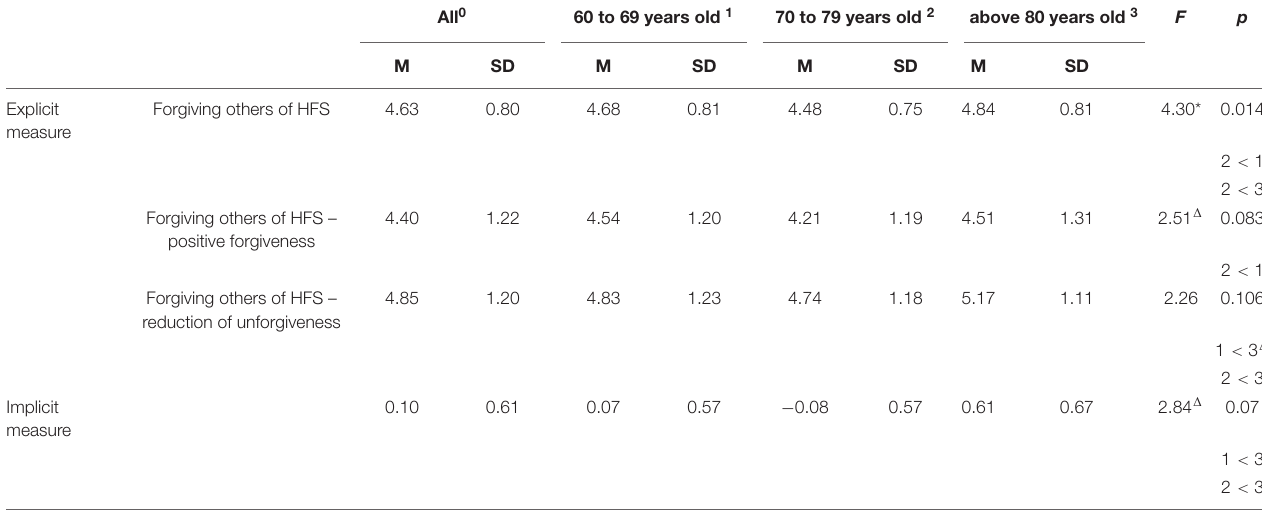
TABLE 2 | Age differences of explicit and implicit